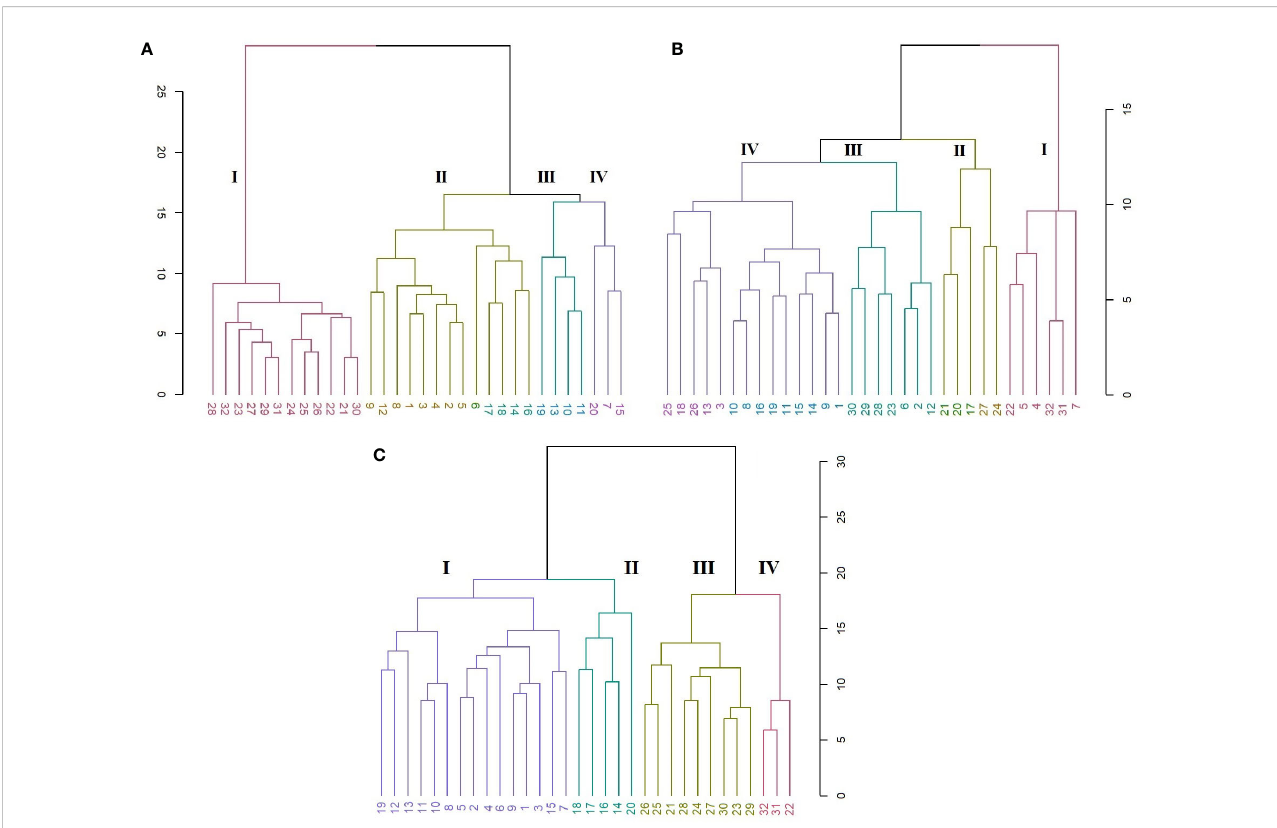
FIGURE 6 HCA representing the genetic relationships among the 32 Cyclamen genotypes from the SRAP ( A ; r =0.95), SCoT ( B ; r =0.82) and combined ( C ; r= 0.93) analysis. Each color represents a different